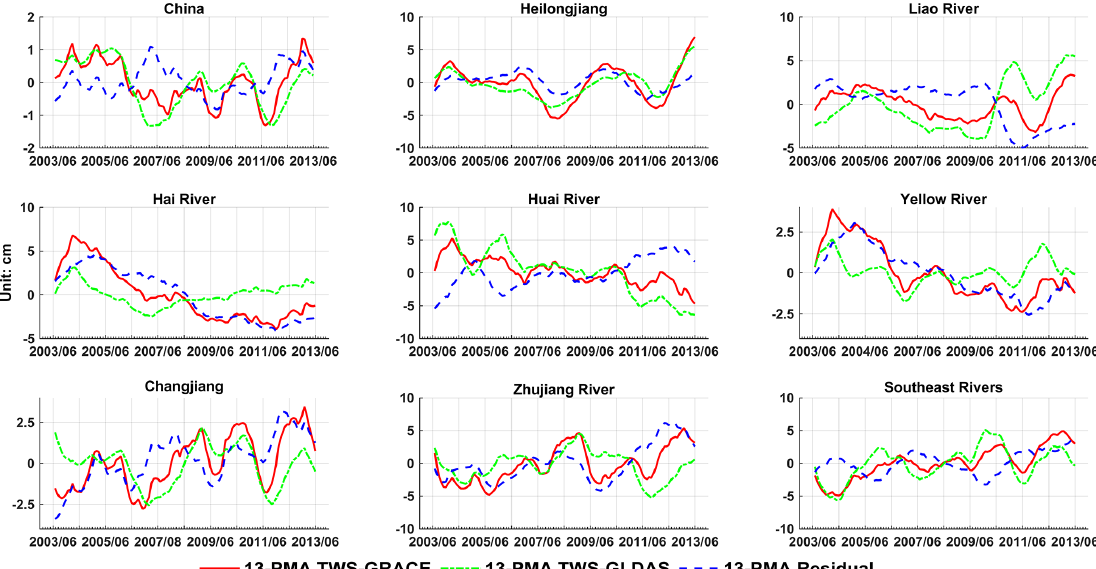
Figure 4. Regionally averaged monthly TWS series (2003–2013) from the scaled GRACE data and the GLDAS ensemble mean, and their residual time series for China and eight of its basins (all time series have been processed with 13-point moving average; unit: cm).